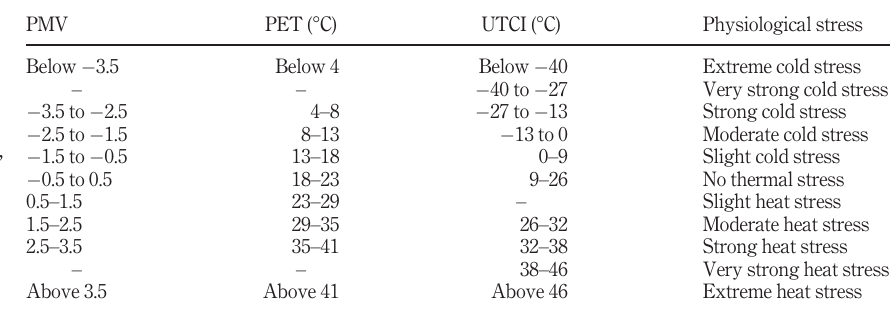
PMV PET (°C) UTCI (°C) Physiological stress Below (cid:3)